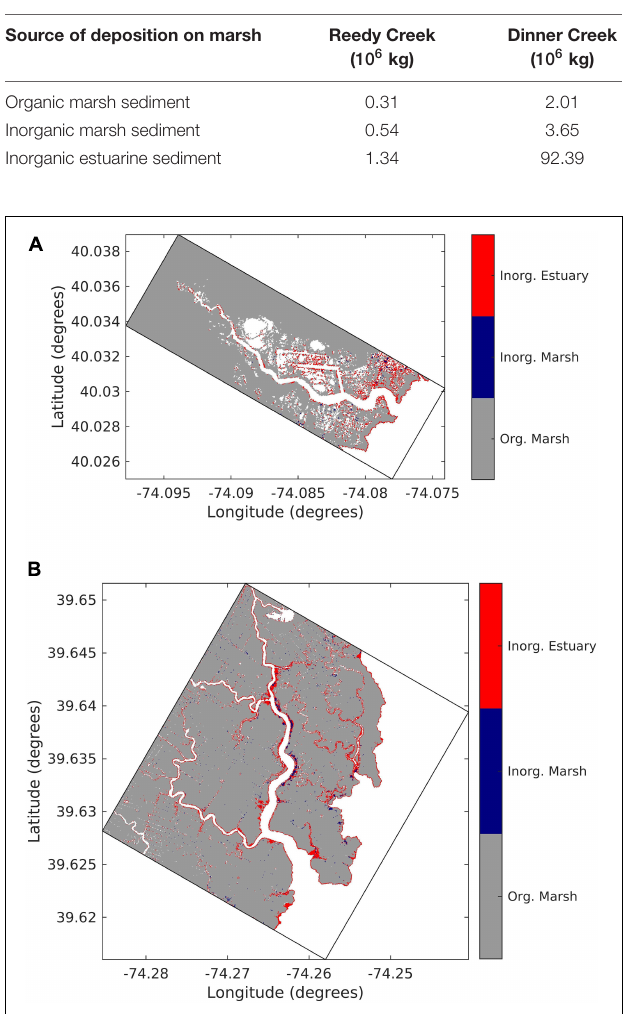
TABLE 1 | Amount of total sediment deposition summed over all grid cells in each marsh complex.